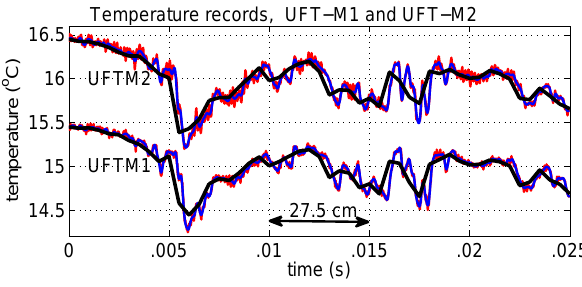
Fig. 8. Temperature fluctuations from two sensing wires of UFT-M. Temperature record from UFT-M2 was shifted up for comparison with that from UFT-M1. Colour code corresponds to that in Fig. 7.